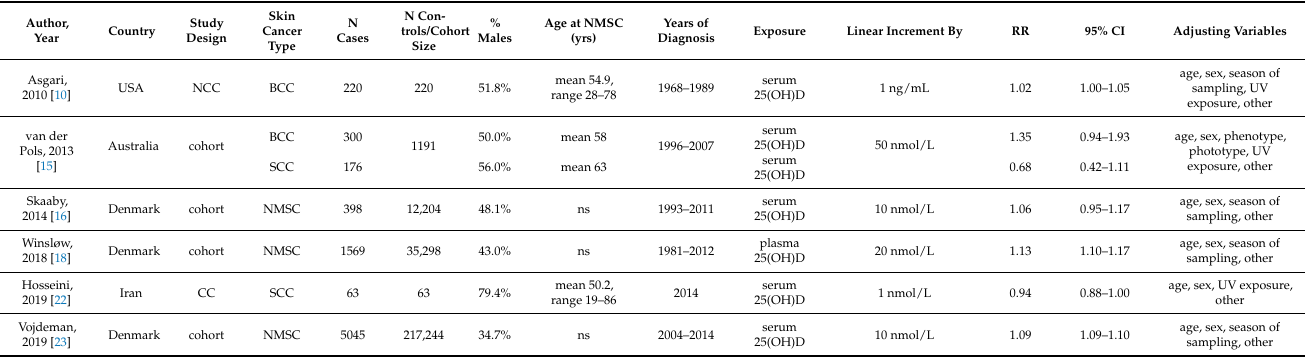
Table 2. Main characteristics of the studies reporting on the linear dose–response association between serum/plasma concentration of 25(OH)D and the risk of non-melanoma skin